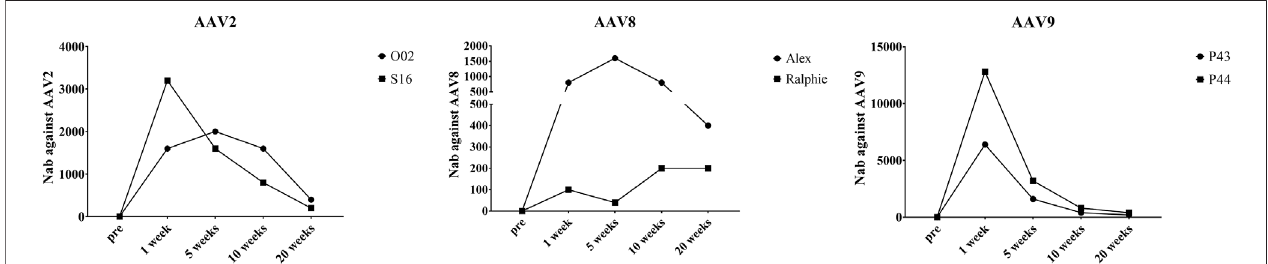
FIGURE 7 | The Nabs against different AAV serotypes in canine plasma after AAV vectors administration. At different timepoints, plasma was obtained from the wholebloodofhemophiliadogsthatwereinjectedwithAAV2,AAV8orAAV9vectorsatadoseof1×10 12 vg/kg.AAV2,AAV8orAAV9/luciferasevectorswereincubated with a serial dilution of plasma. Then, transduction of the pre-incubated AAV2, AAV8, or AAV9/luciferase vectors with the plasma in Huh7 cells at 48 h s was measured via luciferase assay to evaluate the Nab